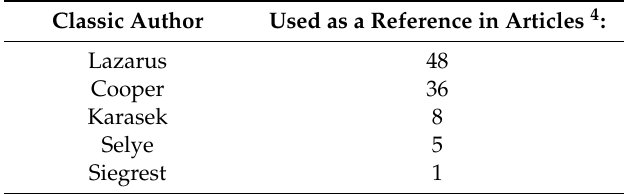
Table 6. Classic author presence in the technostress articles